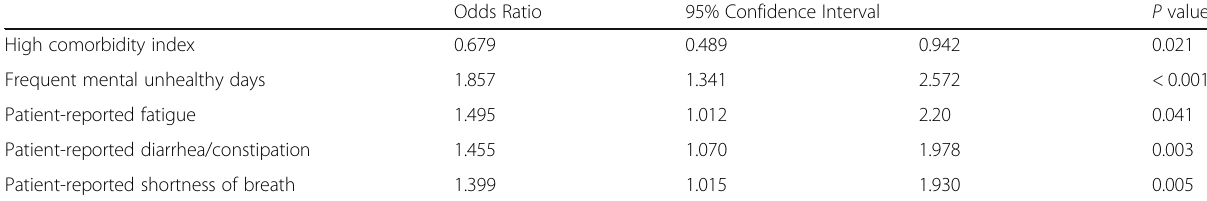
Table 3 Correlates of low comorbidity medication adherence for patients with metastatic breast, lung or colorectal